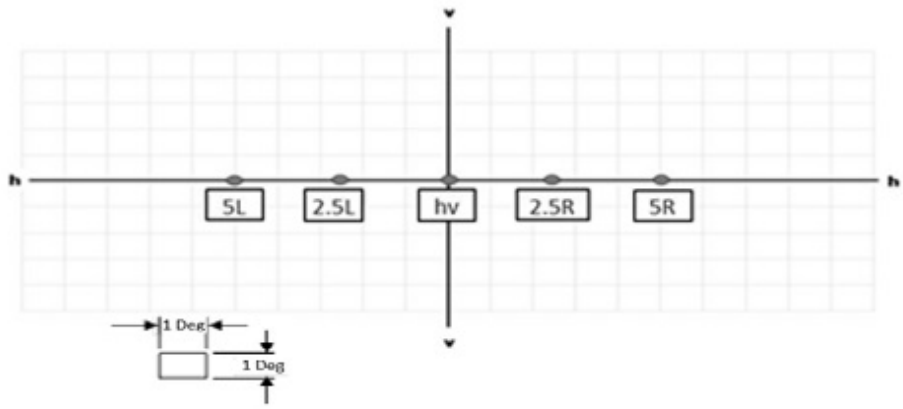
Figure 4. Location of each test point for a high beam. Table 1: ECE R-112 high-beam test specification.